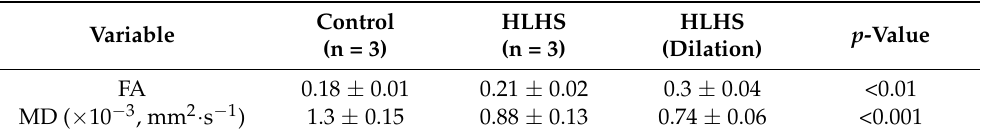
Figure 3. ( A ) MD map in normal fetuses. ( B ) MD map in HLHS fetuses. ( C ) MD values decreased in HLHS fetuses.